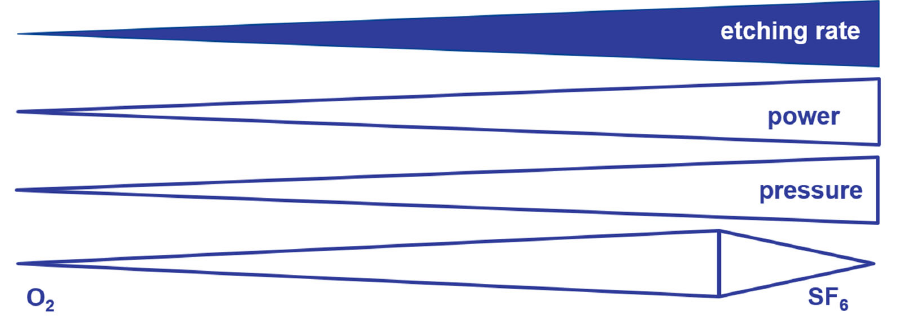
Figure 4. Influence of process parameters on the etch rate.